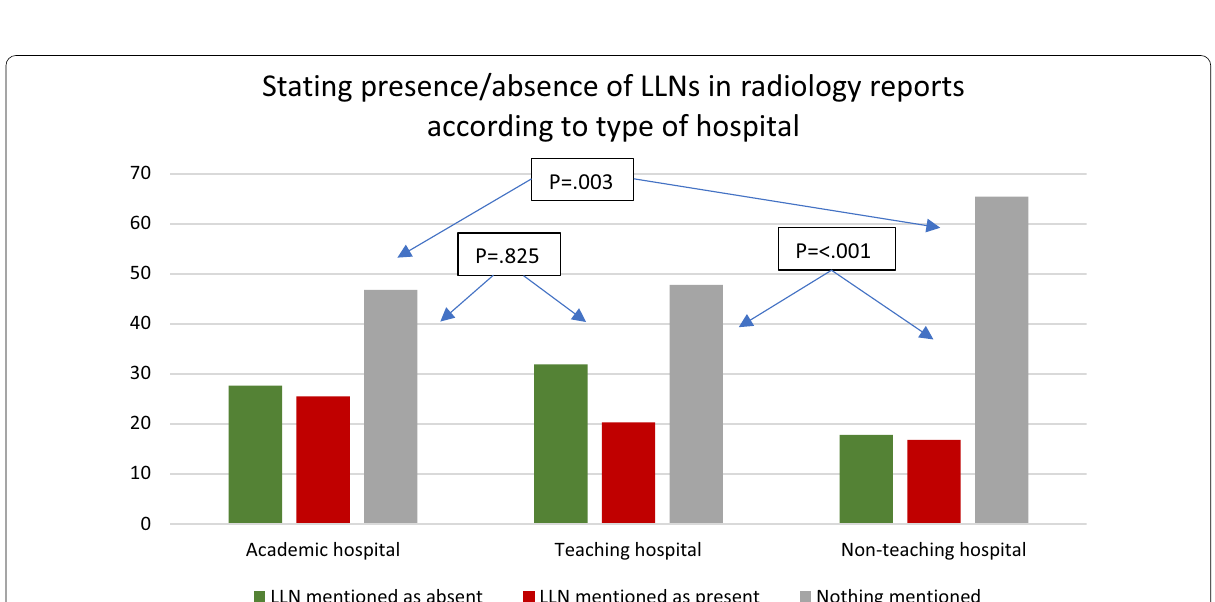
Fig. 3 Stating the presence or absence of LLNs in primary MRI reports according to the type of hospital: academic, teaching or